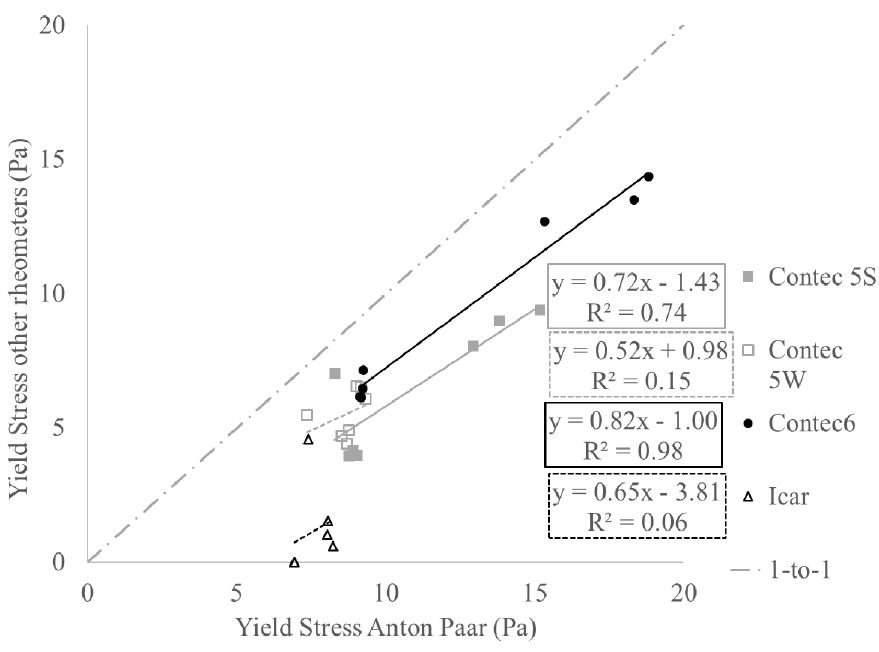
Figure 2. Comparing of yield stress values between all rheometers and the Anton Paar.